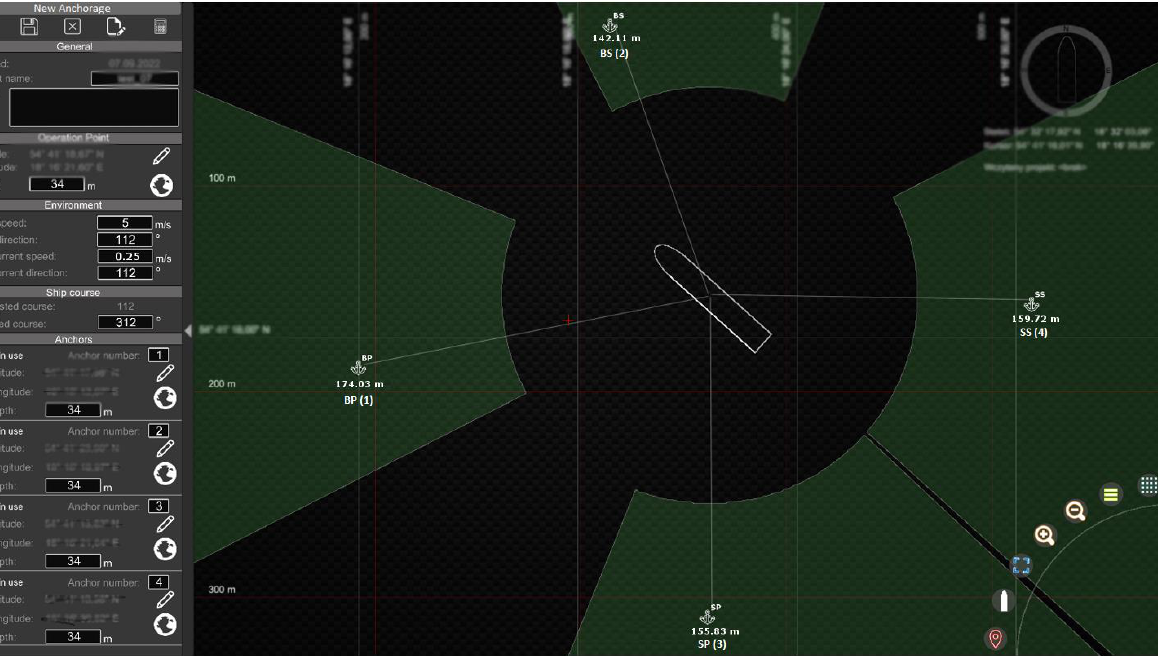
Figure 10. Anchorage planning tool developed in the